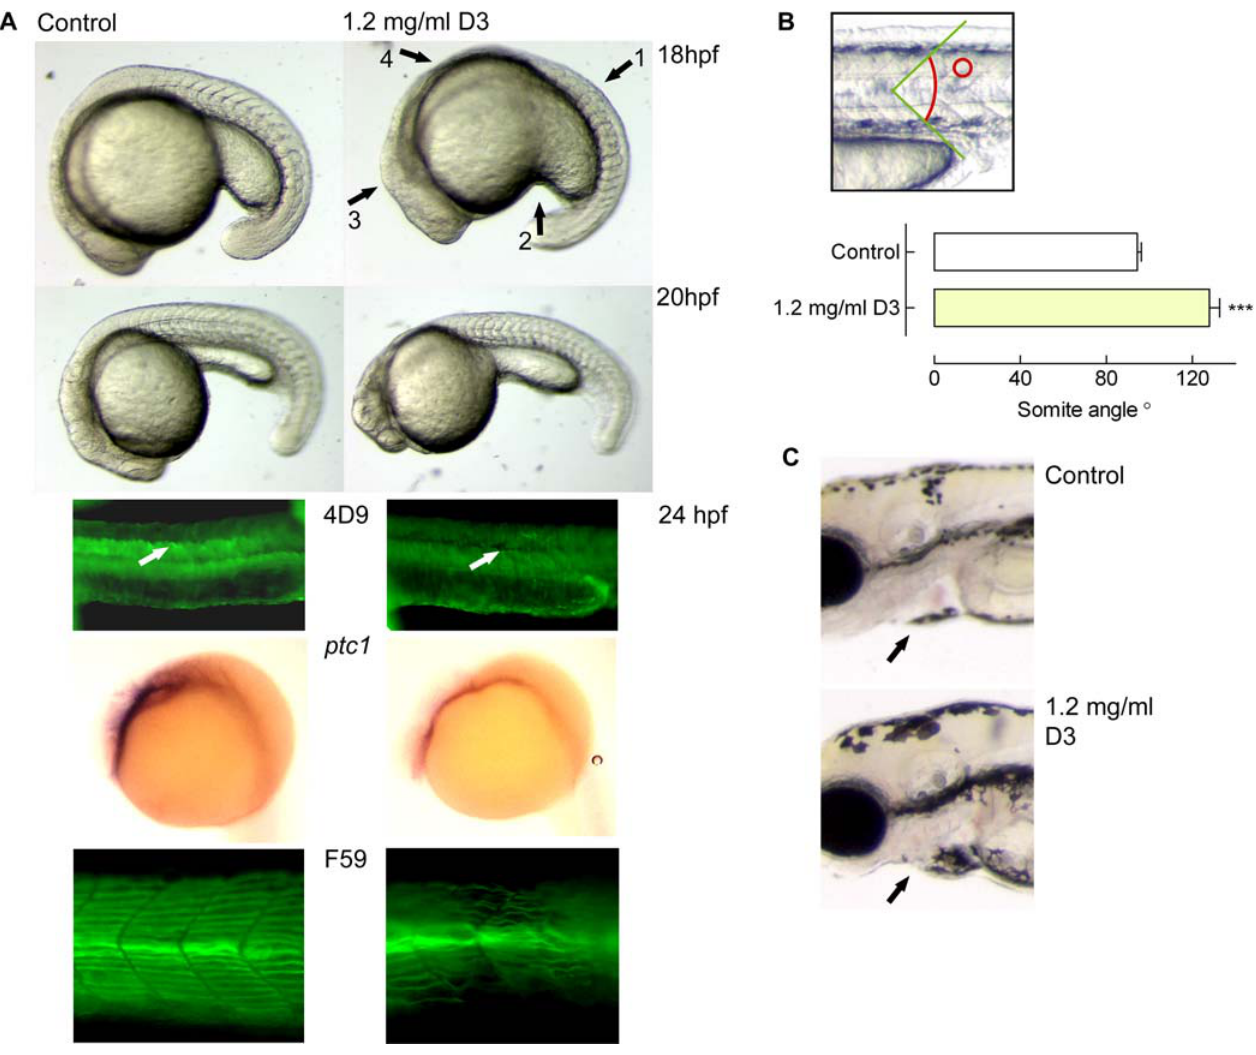
Figure 8. Effects of Vitamin D3 on Developing Zebrafish Embryos (A) Fertilized zebrafish eggs were dechorionated and placed in buffer containing 1.2 mg/ml sonicated vitamin D3, starting the continuous incubation between the 32- and 64-cell stages. At the different developmental stages (as indicated), the embryos were analysed, revealing persistent somite malformations, a ventrally curved body, poorly developed myoseptum, an aberrant extension of the yolk tube, a prominent dorsal midbrain, and a reduced trunk. The wild-type Engrailed staining (4D9) of muscle pioneers and surrounding cells in control-treated animals was not observed upon vitamin D3 treatment. ISH for ptc1 mRNA showed a strongly reduced signal in vitamin D3–treated animals compared with controls. Staining with the F59 antibody revealed that slow muscle fibres were disturbed in number and orientation in the treated animals. (B) At 18 hpf, embryos were photographed in detail and somite angles were determined (as shown in top panel). The measurement was taken of an individual somite between dorsal and ventral portions of the vertical myoseptum for corresponding somites between the wild-type and vitamin D3– treated embryos. Shown are the mean angles ( 6 SEM; n ¼ 3) of wild-type control- and vitamin D3–treated embryos. C) Detail of 4-dpf embryo. Note the slightly enlarged pericardial cavity in vitamin D3–treated animals. The orientation of all images is a lateral view, anterior to the left. DOI: 10.1371/journal.pbio.0040232.g008